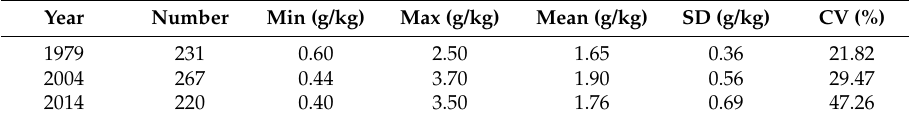
Table 2. Summary of the statistics of the soil TN datasets in Fuyang District.